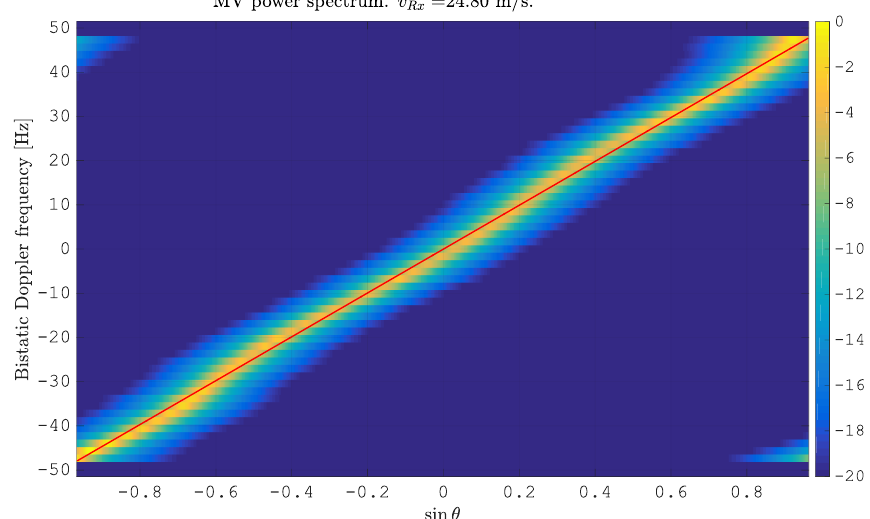
Figure 3. Minimum variance power spectrum estimated from simulated clutter for N = 2 spatially displaced antenna elements with antenna pattern errors in amplitude and phase. The red line indicates the ideal slope of the